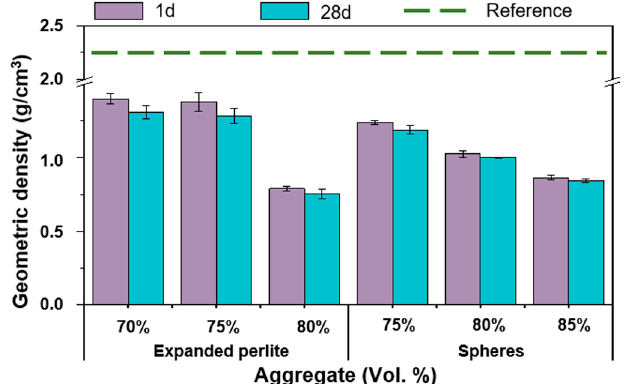
Figure 3. Geometric density of geopolymer composites varying the amount of expanded perlite and geopolymer spheres (measured on the 1st and 28th day). Reference means the control specimen without addition of lightweight aggregate.